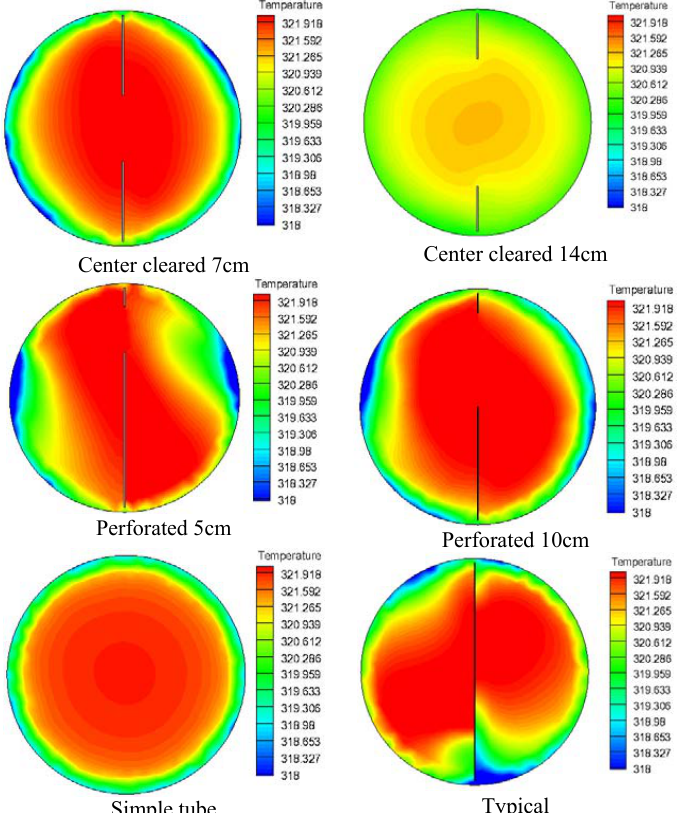
Fig. 9. Temperature contours at the exit area of tube geometries Fig .9 Temperature contours at the exit area of tube geometries Fig .9 Temperature contours at the exit area of tube geometries